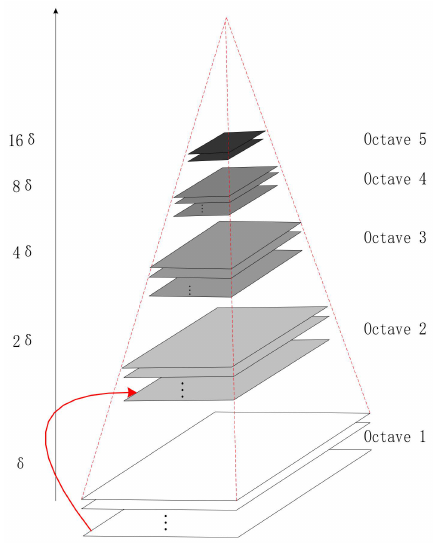
Figure 3. Gaussian